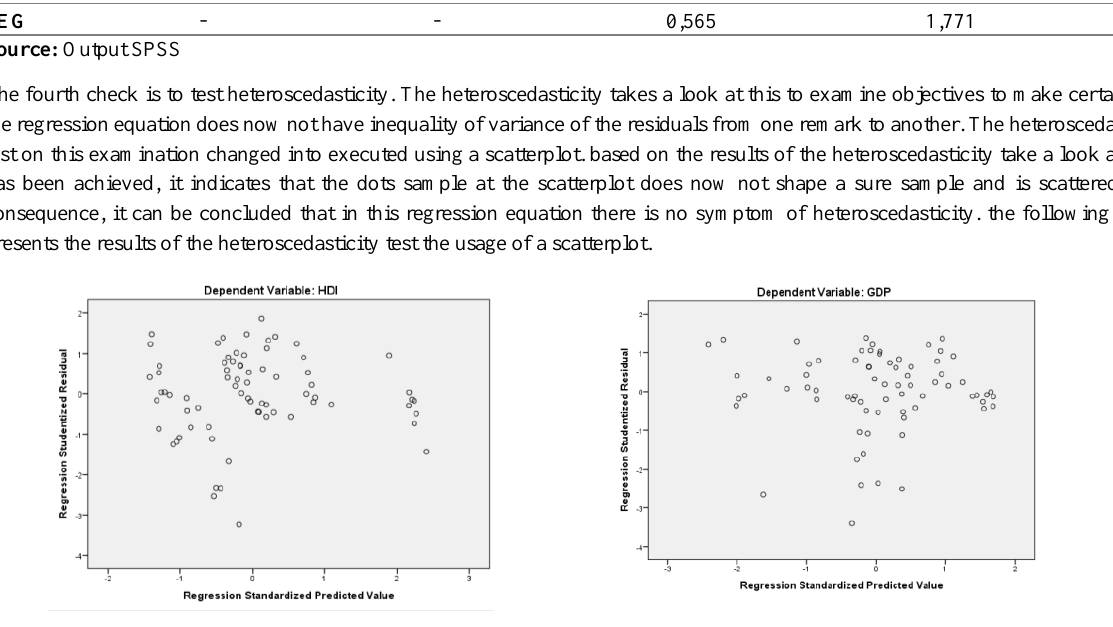
Figure 3: Scatterplot; Source: Output